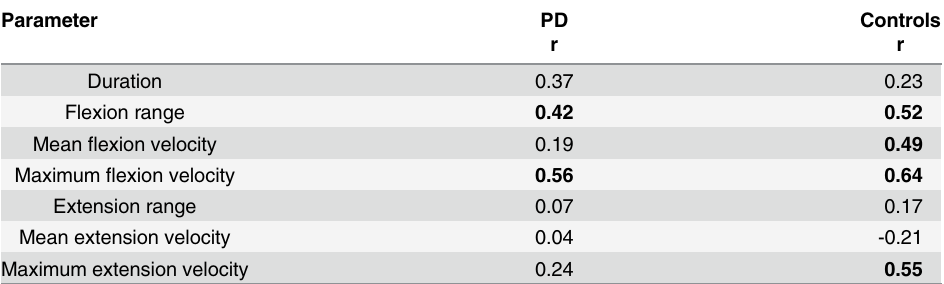
Maximum extension velocity 0.55 Pearson ’ s correlation coef fi cients (r) of the corresponding parameters of the sit-to-walk and the walk-to-sit sub-phases, presented for the Parkinson ’ s disease (PD) and controls. Signi fi cant values are in bold. Note that PD patients had a higher correlation value than controls for the correlation of duration, but lower values for all other (kinematic) parameters.